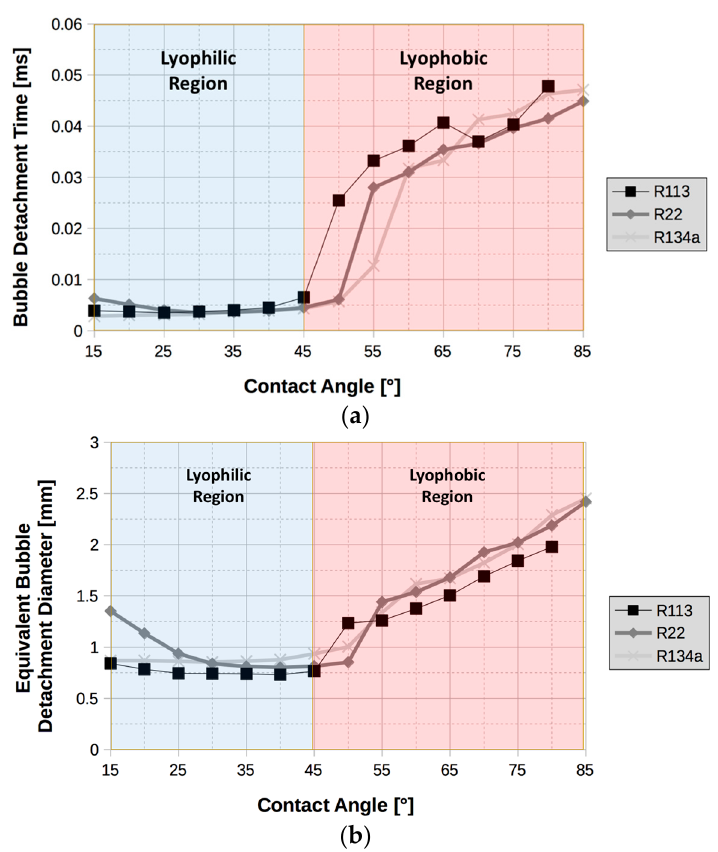
Figure 17. Effect of contact angle on: ( a ) the bubble detachment time; ( b ) the equivalent bubble detachment diameter. Energies 2017 , 10 , 272